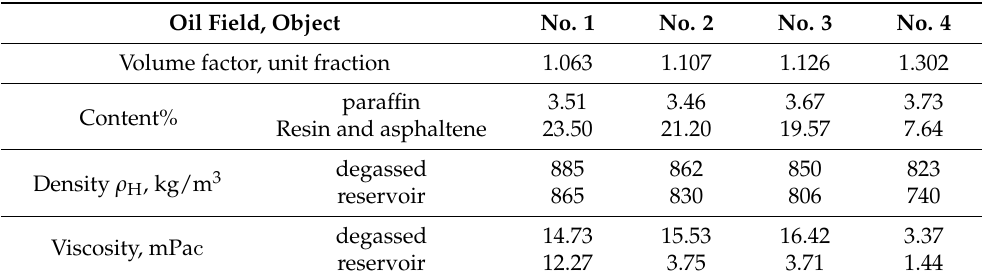
Table 1. Physicochemical properties of the studied fluids.